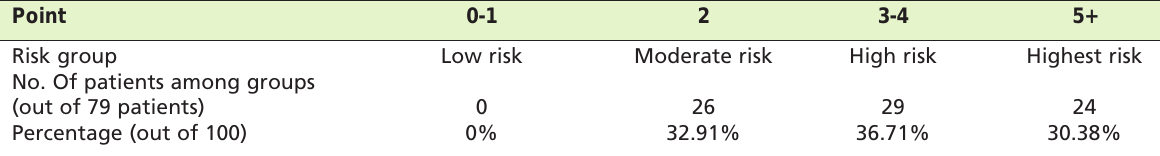
Distribution of patients according to the risk groups Table IV: